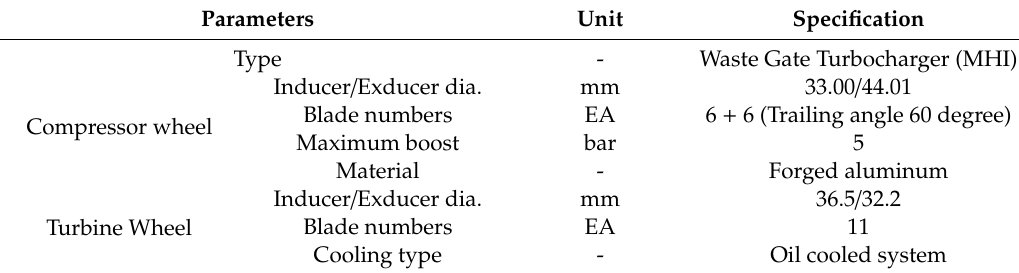
Table 3. Turbocharger